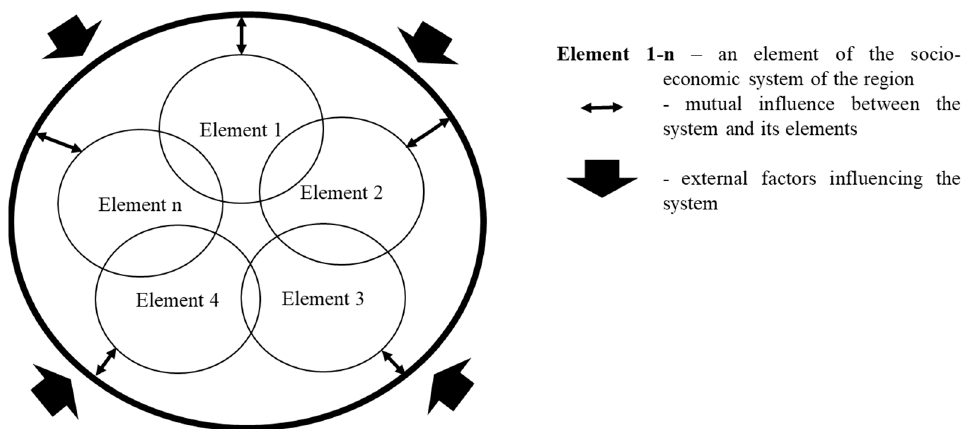
Figure 1. System of economic security of a region .